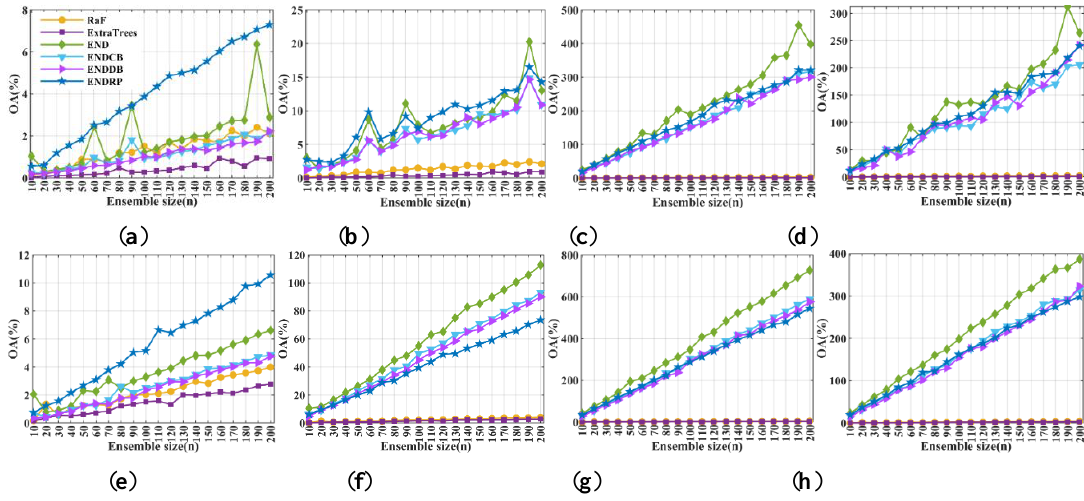
Figure 9. CPU runtime in seconds versus the ensemble sizes of the END, ENDCB, ENDDB, and ENDRPS frameworks with the ERDT ( a , e ), C4.5 ( b , f ), RaF ( c , g ), and ExtraTrees ( d , h ) classifiers using the original raw bands ( a , b , c , d ) and features from the MPs ( e , f , g , h ).